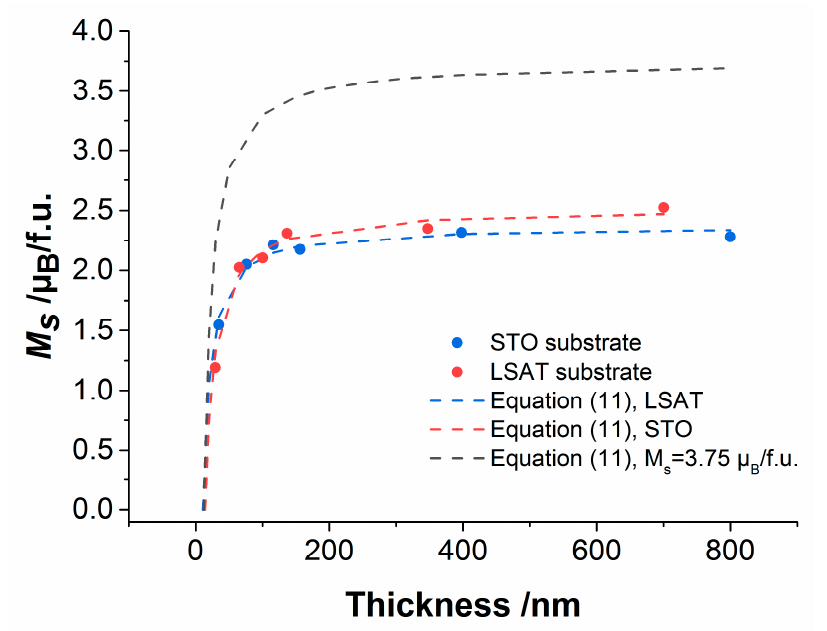
Figure 4. Thickness dependence of the saturation magnetization M s of SFMO thin films measured in a magnetic field of 400 mT at 10 K [76] in comparison with the DL model (Equation (11)). Additionally, an outlook is given for high-quality SFMO thin films possessing a saturation magnetization of 3.75 µB/f.u.